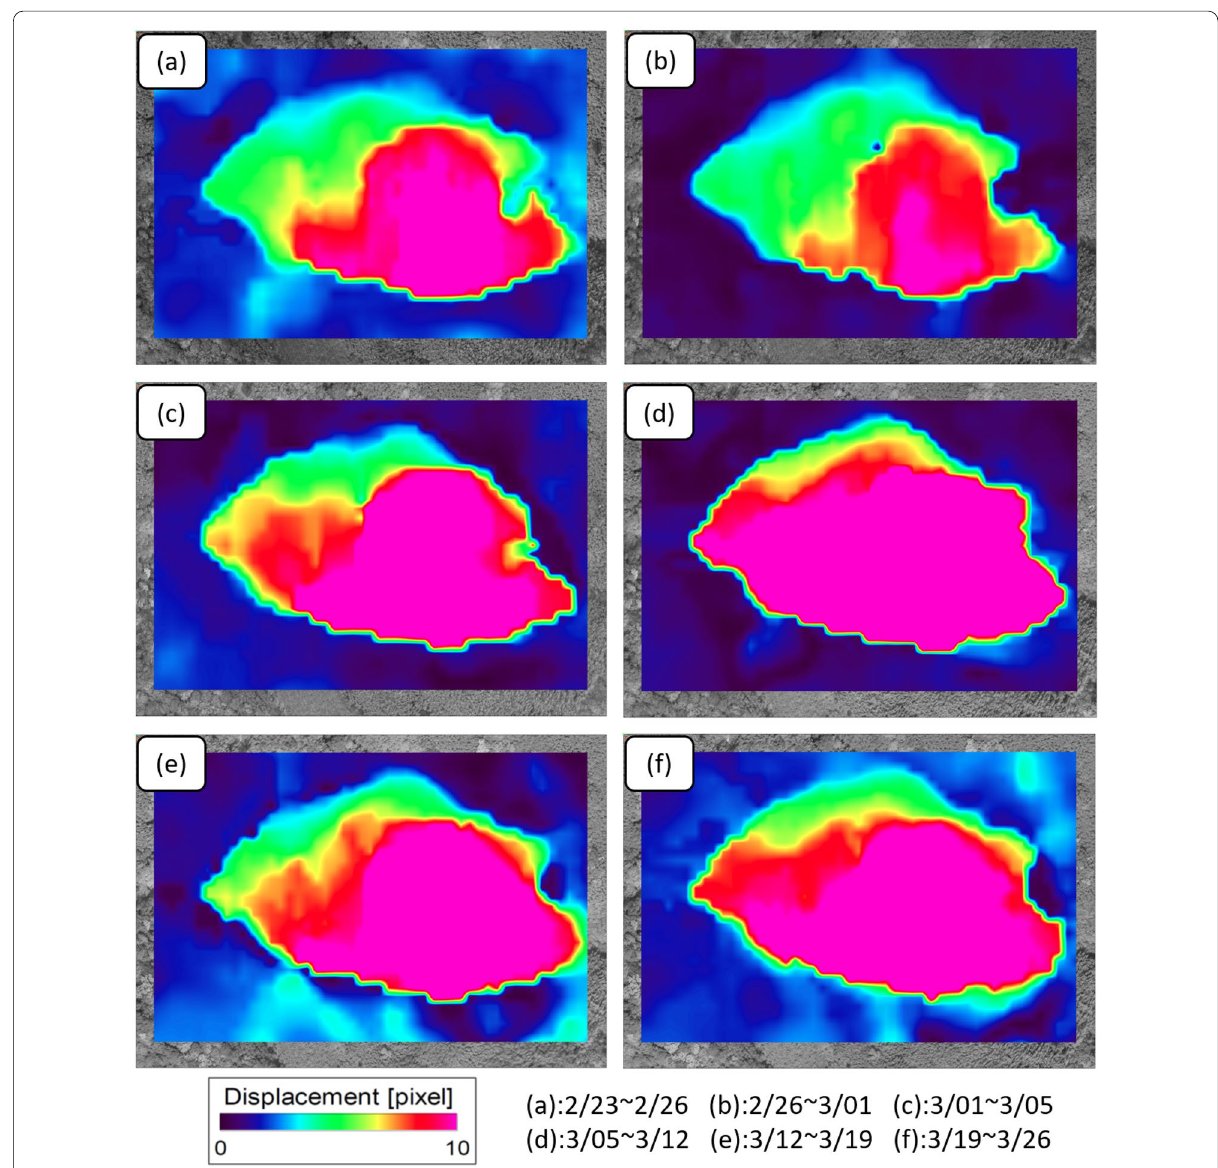
Fig. 16 Color gradient map of the PIV displacement analysis results for the study